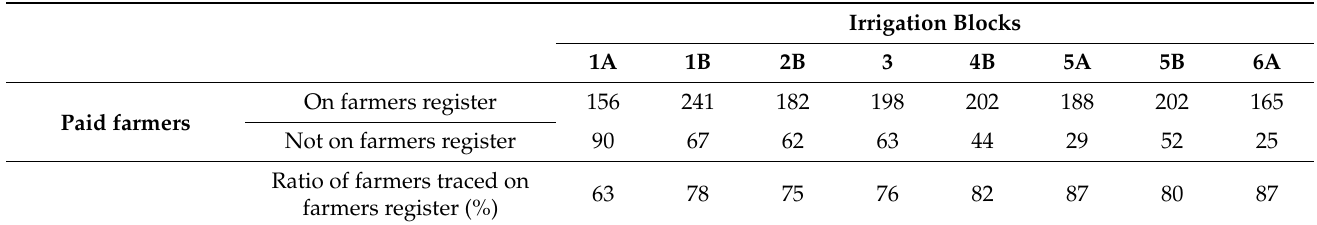
Table 2. Payment list distribution and the ratio of farmers traced on the farmers’ register.